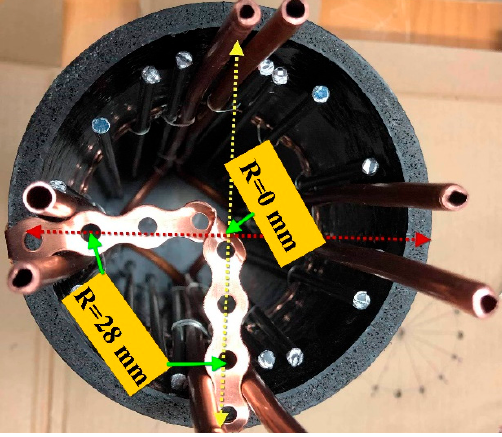
Figure 4. Symmetry lines and thermocouples locations.